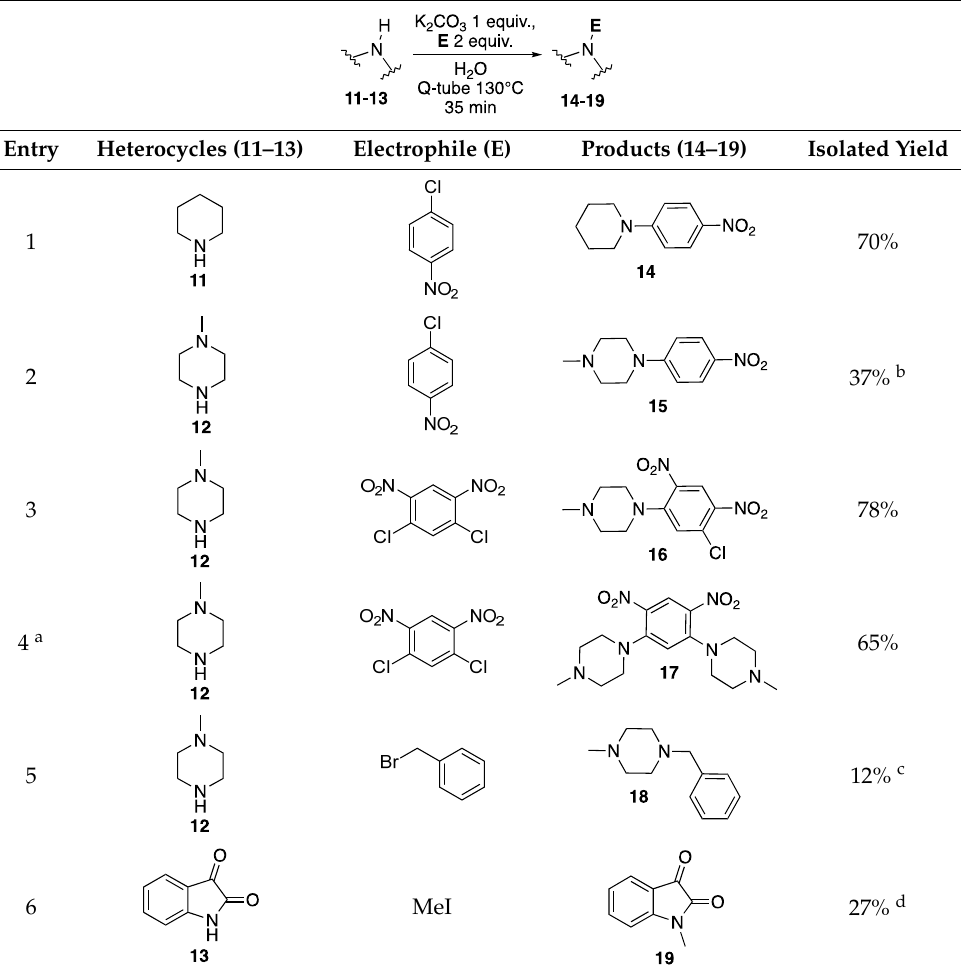
Table 3. Scope of the N -arylation reaction.